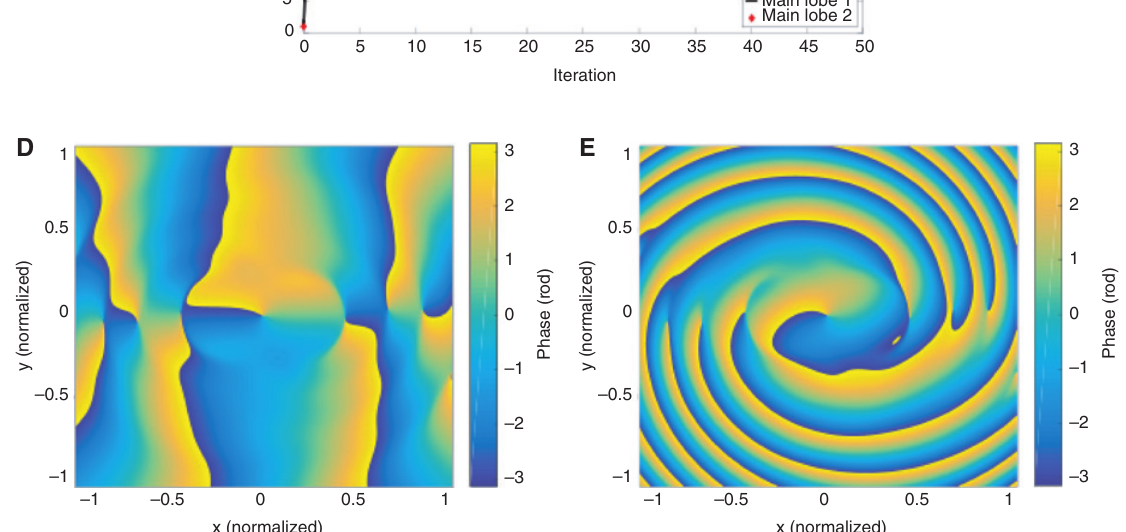
0.5 x (normalized) Figure 1: Theoretical design of high-efficiency DH-PSF and DH-metalens. (A–B) Intensity and phase distributions of the exact DH-PSF. (C) Iteration curve of the peak intensity of main lobes during the optimization iteration procedure. An enhancement of 40 times is obtained after the optimization. (D) Phase distribution of the optimized phase-only transfer function to realize high-efficiency DH-PSF. (E) Phase distribution of the designed metasurface combining the high-efficiency DH-PSF and a lens with focal length of 2.54